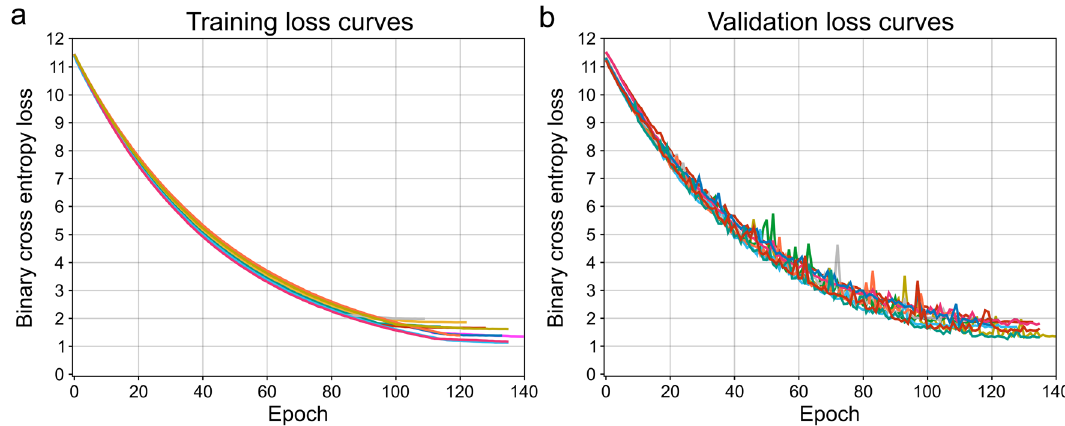
Figure 3. Loss curve plots of best performing training condition. ( a ) Training loss (binary cross entropy) is plotted against number of epochs for each model trained on the dataset of condition 4 (see Table 1) with Monte-Carlo cross-validation. ( b ) Validation loss (binary cross entropy) is plotted against number of epochs for each model trained on the dataset of condition 4 (see Table 1) with Monte-Carlo cross-validation. Both plots show decrease in loss over model training time, and start to converge around 120 epochs. Early stopping was employed when validation loss would not improve over 10 epochs. The loss function includes